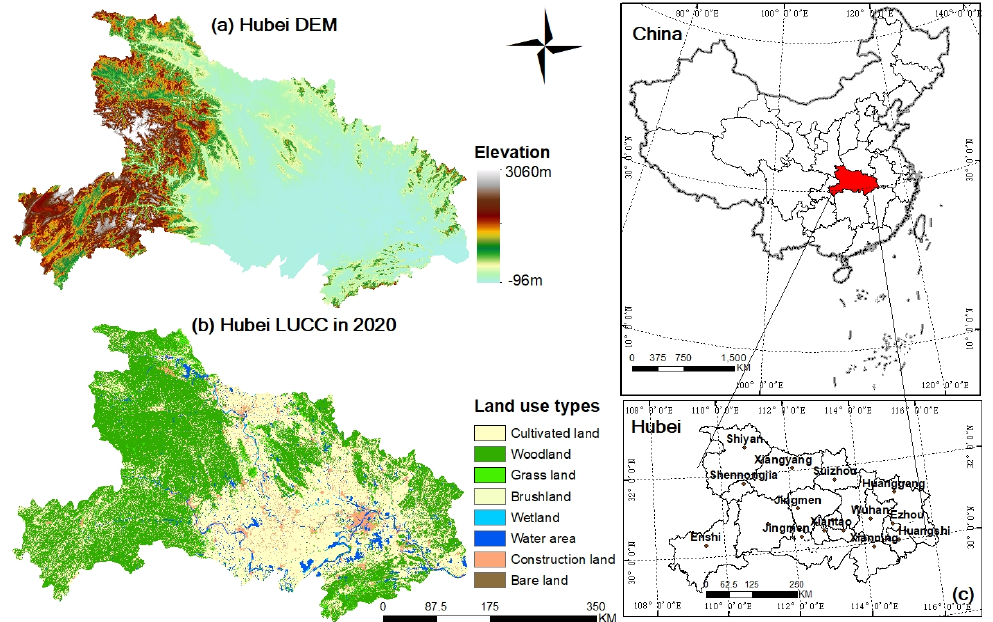
Figure 2. ( a ) The Digital Elevation Model (DEM) of Hubei; ( b ) The Land-Use and Land-Cover Change (LUCC) of Hubei in 2020. ( c ) Location of the study area. 2020. ( c ) Location of the study